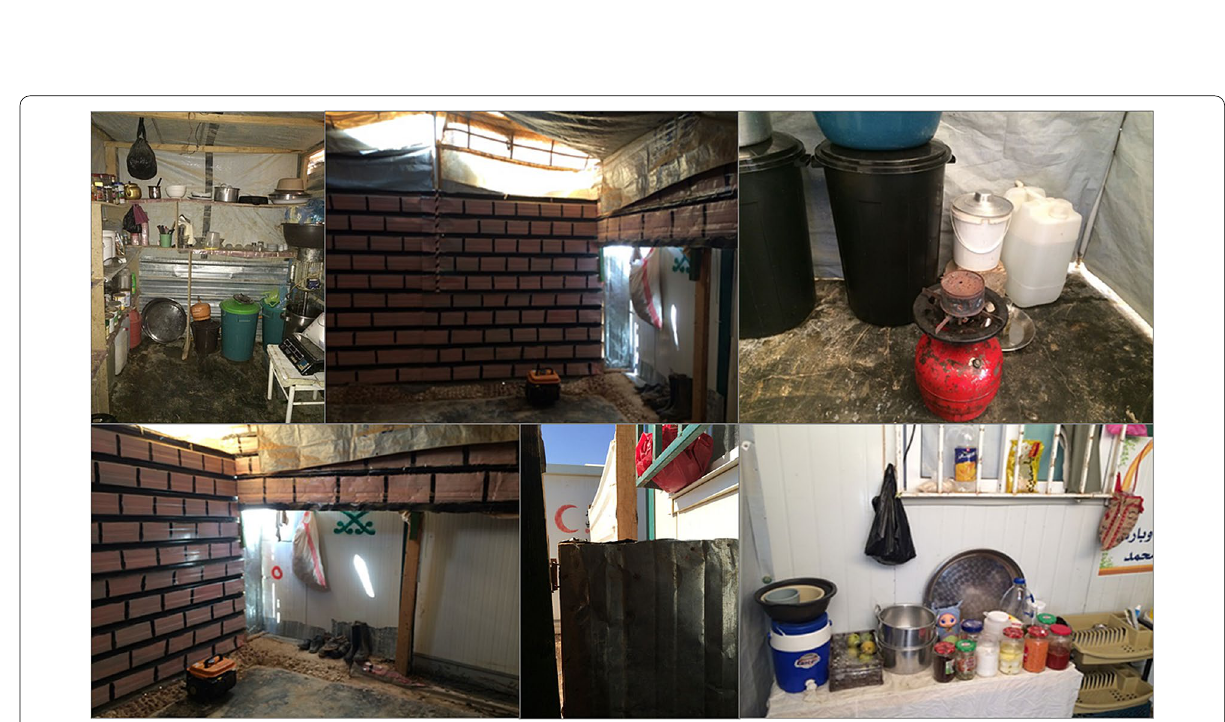
Fig. 7 Refugee created semi-outdoor socio-cultural spaces in the Al Za’atari camp in Jordan (Source: Author